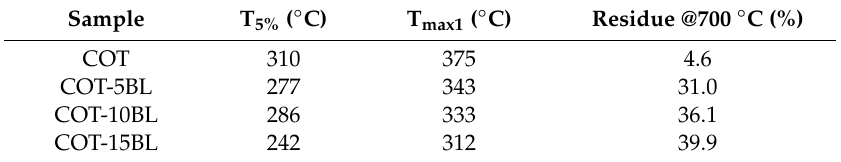
Table 20. Results from the thermogravimetric analyses carried out in inert atmosphere.